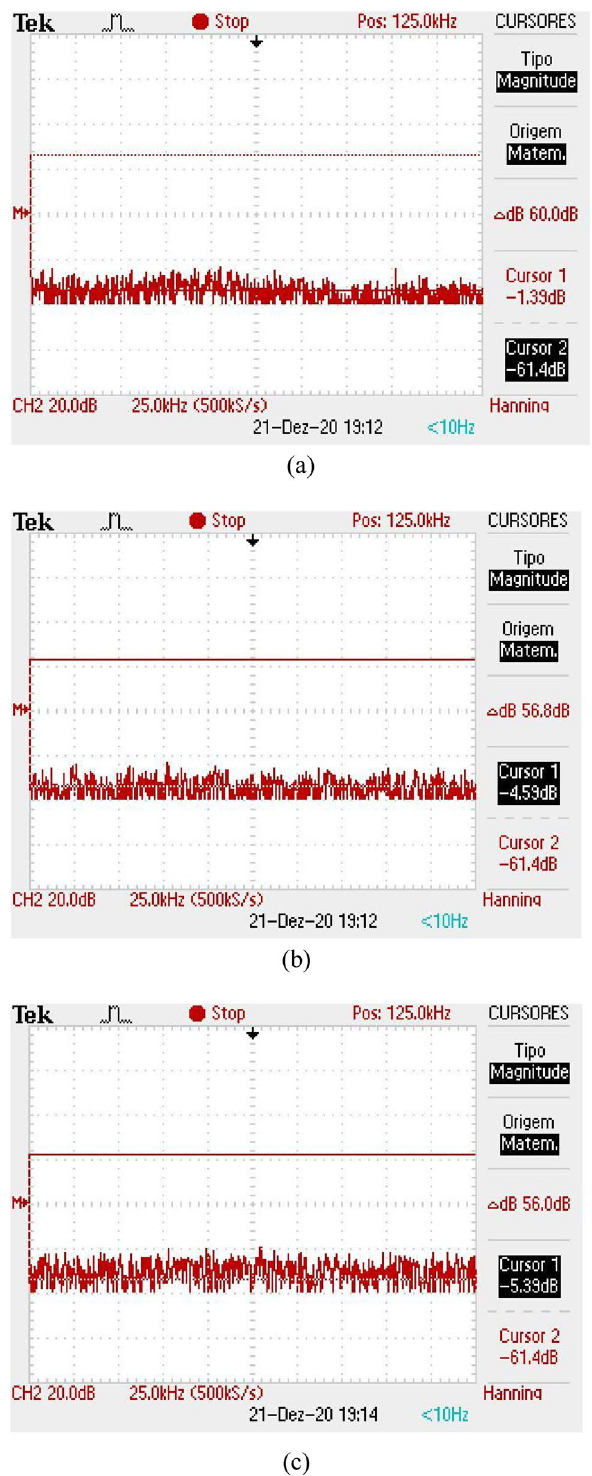
Figure 12. Reading of the noise level in frequency domain for the first version of the Osseus : ( a ) without finger, ( b ) with finger in the correct decision and ( c ) with the finger in the rotated